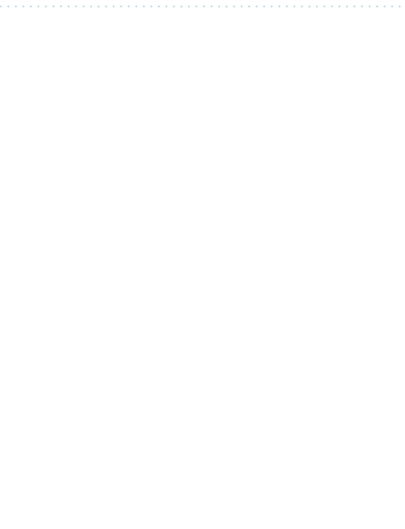
Figure 1. X-tile analysis of CSS in the development cohort. a X-tile plot. b histogram plot.